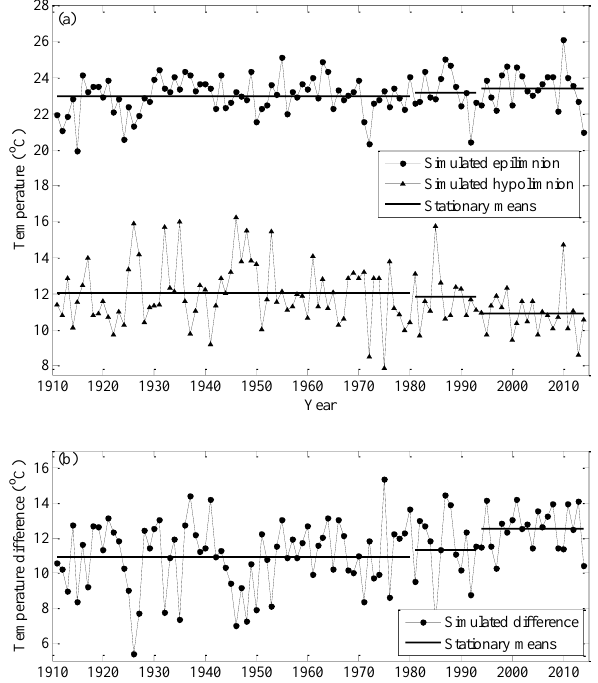
Figure 9. (a) Simulated midsummer (16 July–15 August) volume-averaged epilimnion and hypolimnion temperatures, and (b) epilimnion–hypolimnion temperature difference. Stationary means for three selected periods are denoted by solid lines.